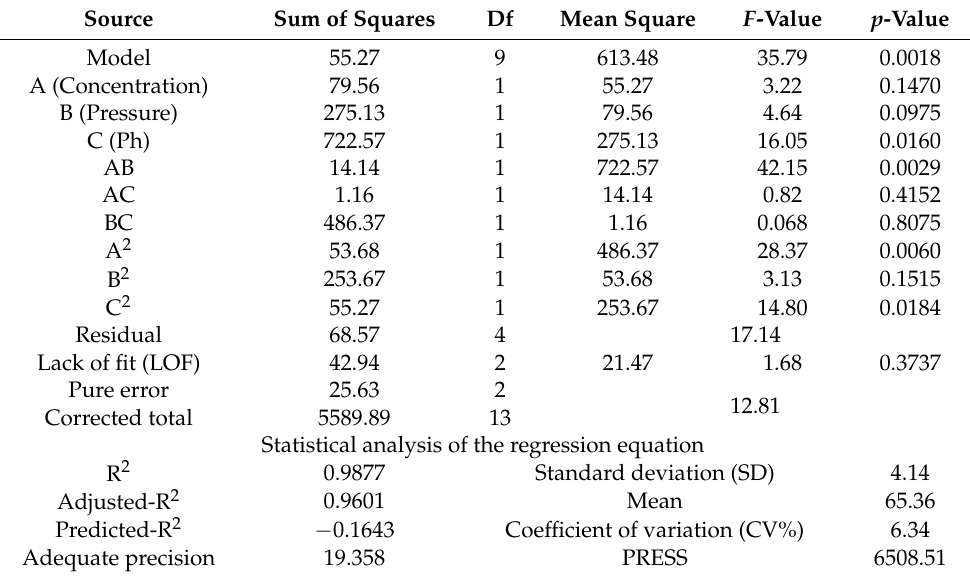
Table 4. Analysis of variance (ANOVA) of the quadratic